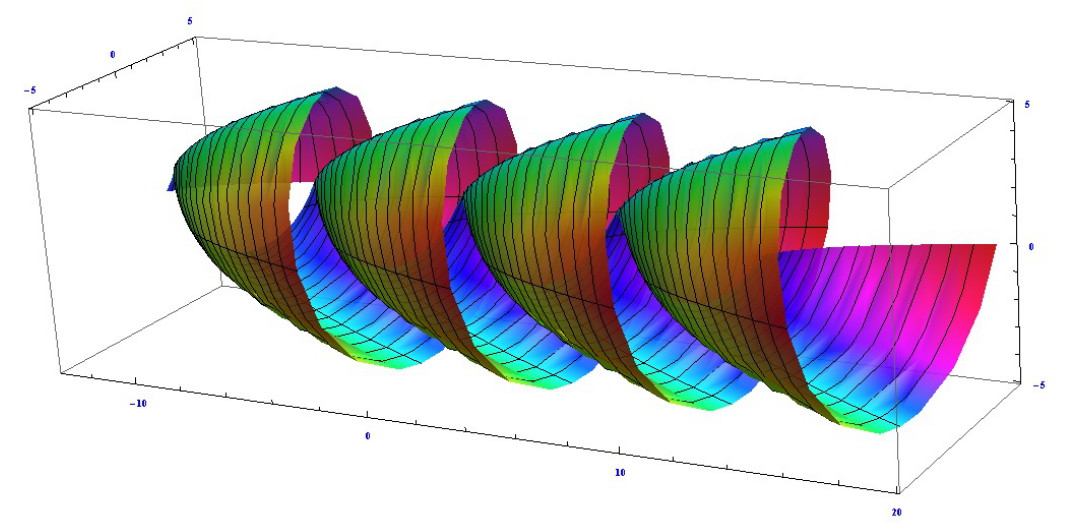
Figure 1. Helical surface having a time-like